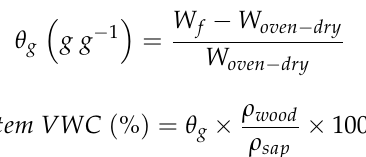
Figure 6. Precipitation (PPT (mm)) and vapor pressure deficit (VPD (kPa)) for 2020, based on data from the climate station in the Marburg Open Forest (MOF) study area.